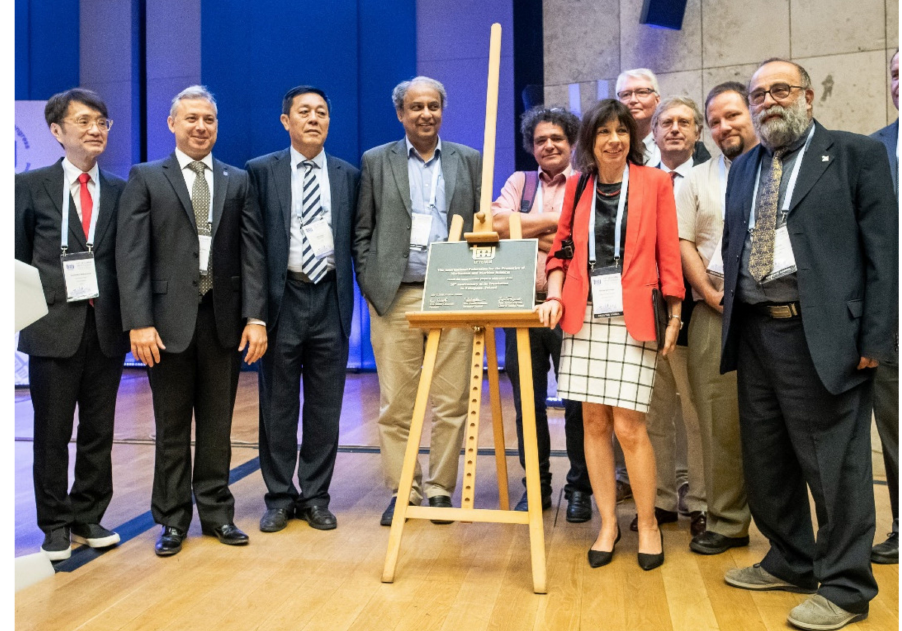
Figure 6. The members of the current IFToMM Executive Council with the commemorative plaque in exhibition (from left to right): Prof. Yoshihiko Nakamura, Prof. Can Dede, Prof. Tian Huang, Prof. Ashitava Ghosal, Dr. Jean-Pierre Merlet, Prof. Teresa Zielinska, Prof Burkard Corves, Prof. Fernando Viadero, Prof. Juan Antonio Carretero, and Prof. Marco